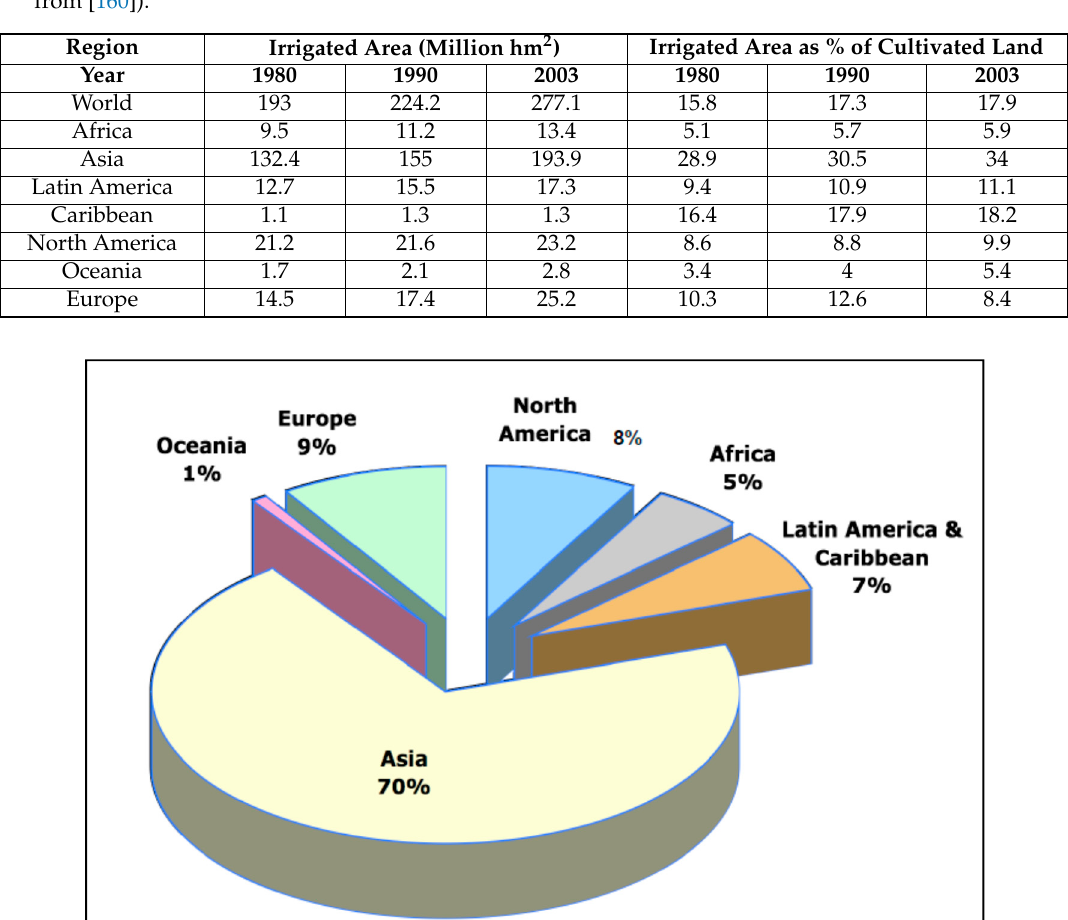
Figure 23. Distribution of irrigated surface in the World by major geographic regions (adapted from [160]).